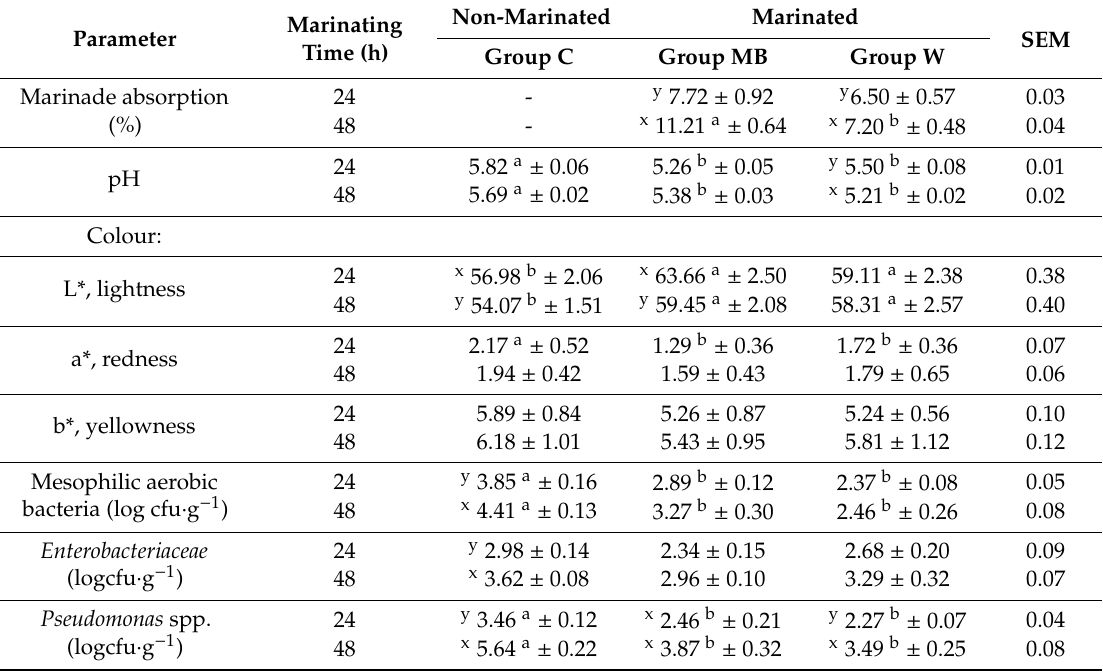
Table 1. E ff ect of marinating on physical and microbiological characteristics of raw products. Parameter